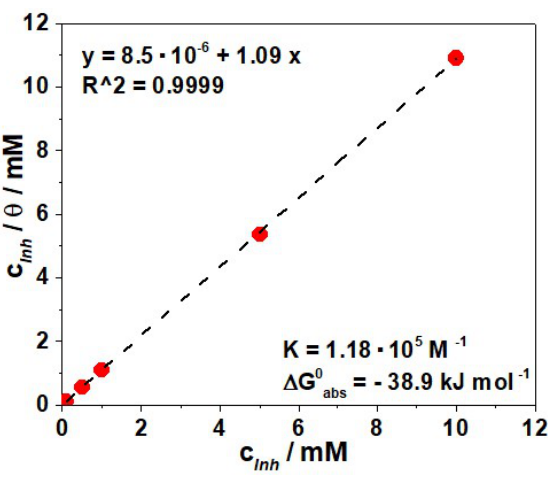
Figure 7. Langmuir adsorption isotherm for C-steel in 1.0 M HCl solution containing PyODT. The value of the equilibrium constant (K = 1.18 × 10 5 M −1 ) obtained from the Langmuir plot is high and implies strong interactions between the organic inhibitor molecules and the metal surface. The standard free energy of adsorption Δ𝐺 (cid:3028)(cid:3031)(cid:3046)(cid:2868) was further calculated based on the K value, according to Equation (7):